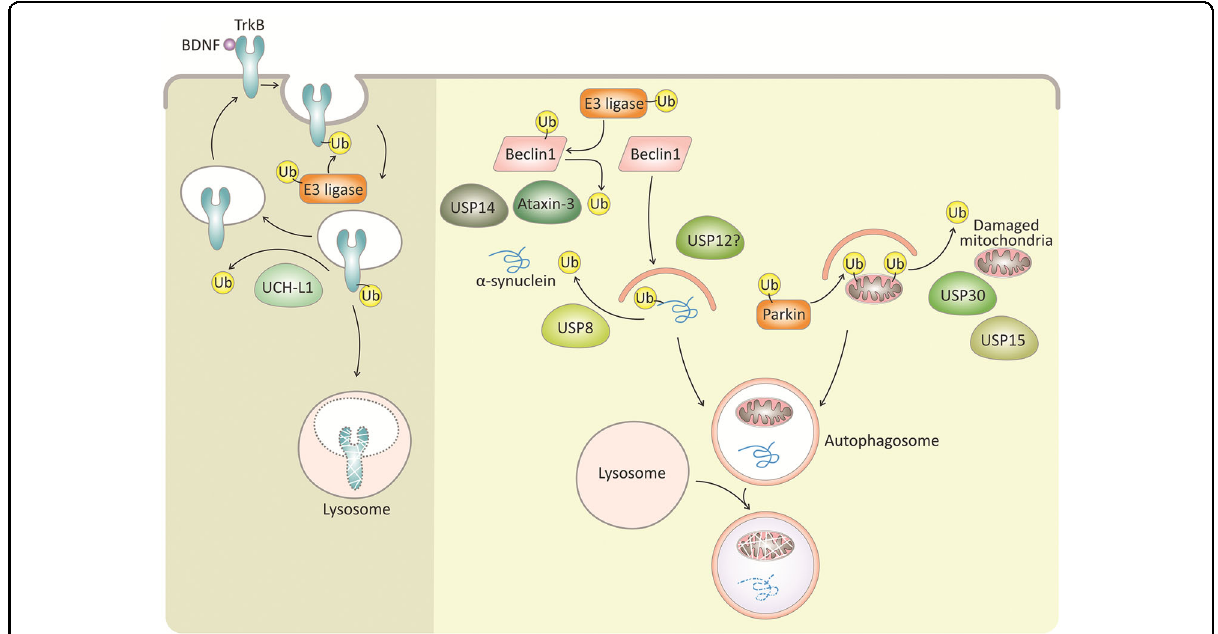
Fig. 4 DUB involvement in neuron survival under normal conditions and in response to stressors. The cell survival tyrosine receptor kinase B (TrkB) is activated by BDNF and is ubiquitylated by E3-ligases for degradation. The DUB, UCH-L1, deubiqutylates TrkB and thereby regulates TrkB levels and surface localization. The accumulation of aggregate-prone proteins (for example, α -synuclein) and damaged mitochondria are associated with neuronal loss in neurodegenerative diseases, such as Parkinson ’ s disease. These proteins and damaged mitochondria are ubiquitylated by E3-ligases (for example, parkin ubiquitylation of damaged mitochondria) and are engulfed by autophagosomes for degradation in the lysosome. A number of DUBs antagonize autophagy-mediated degradation of damaged mitochondria (USP30 and USP15) and α -synuclein (USP8). Moreover, other DUBs (ataxin-3, USP14 and USP12) are involved in promoting neuronal autophagy. DUBs with yet unknown substrates are labeled with a question mark (?). The Ub symbol in this image indicates a polyubiquitin